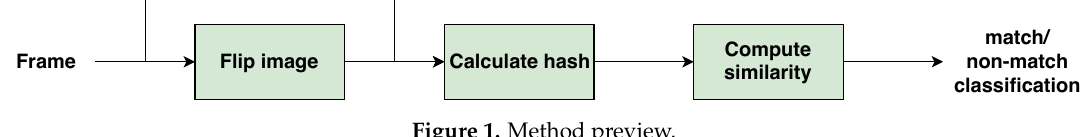
Figure 1. Method